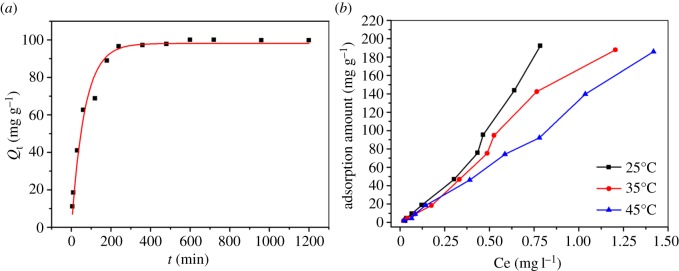
Adsorption kinetics curve of DnPP at 25°C (a) and adsorption isotherms of DnPP at 25°C, 35°C and 45°C (b) by Fe@SiO2@MIP nanocomposites.